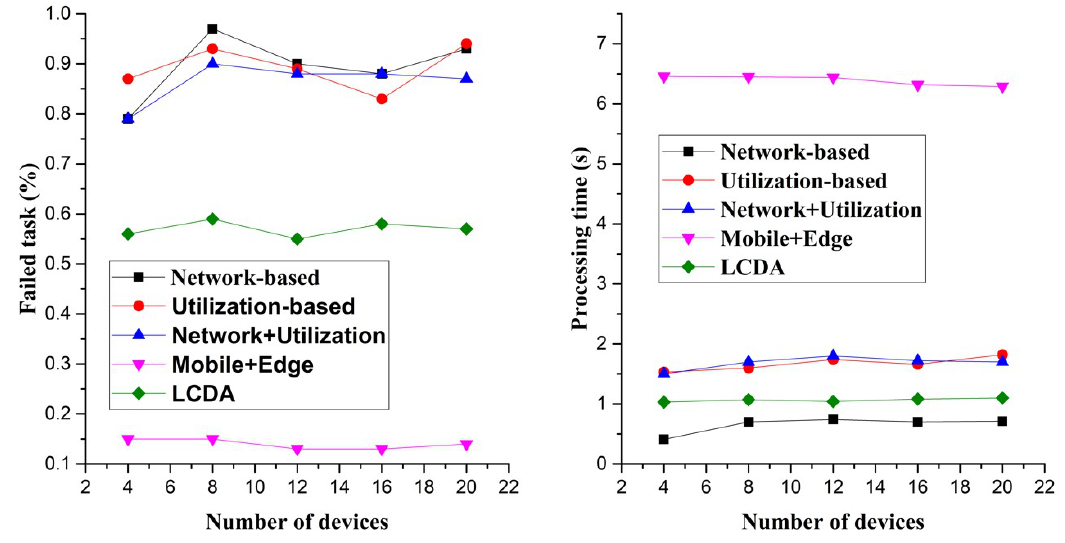
Figure 5. Performance comparison for the number of applications.